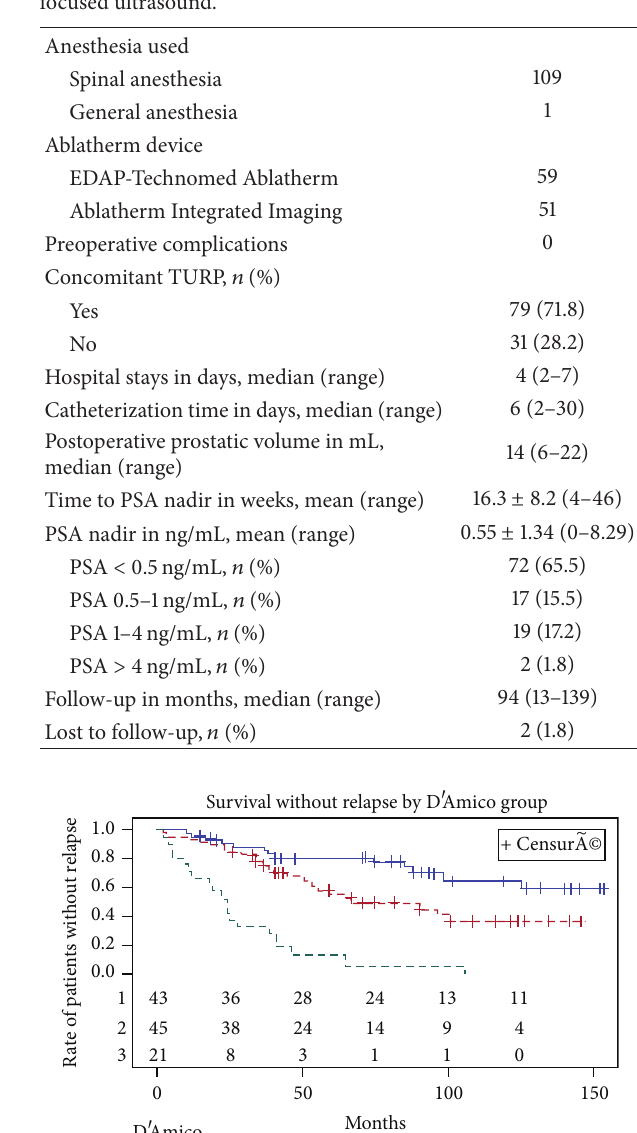
Table2:Intraoperativeandpostoperativeresultswithhighintensity focused ultrasound.